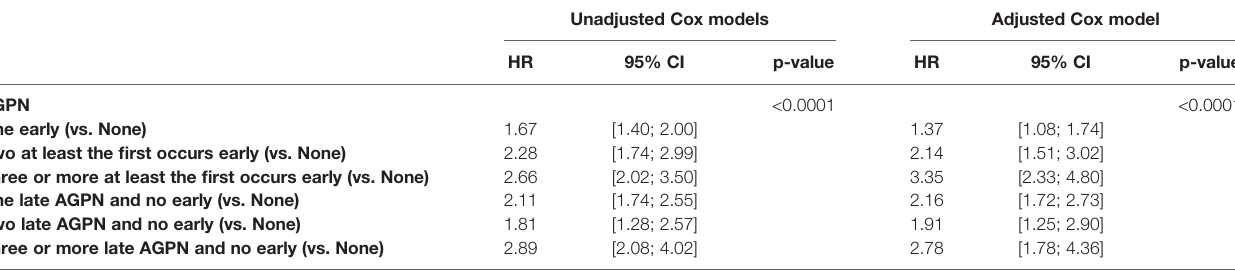
TABLE 3 | Results of the unadjusted (univariate) and multivariable cause-speci fi c time-dependent Cox models strati fi ed on center studying the risk of graft failure or death. Unadjusted Cox models